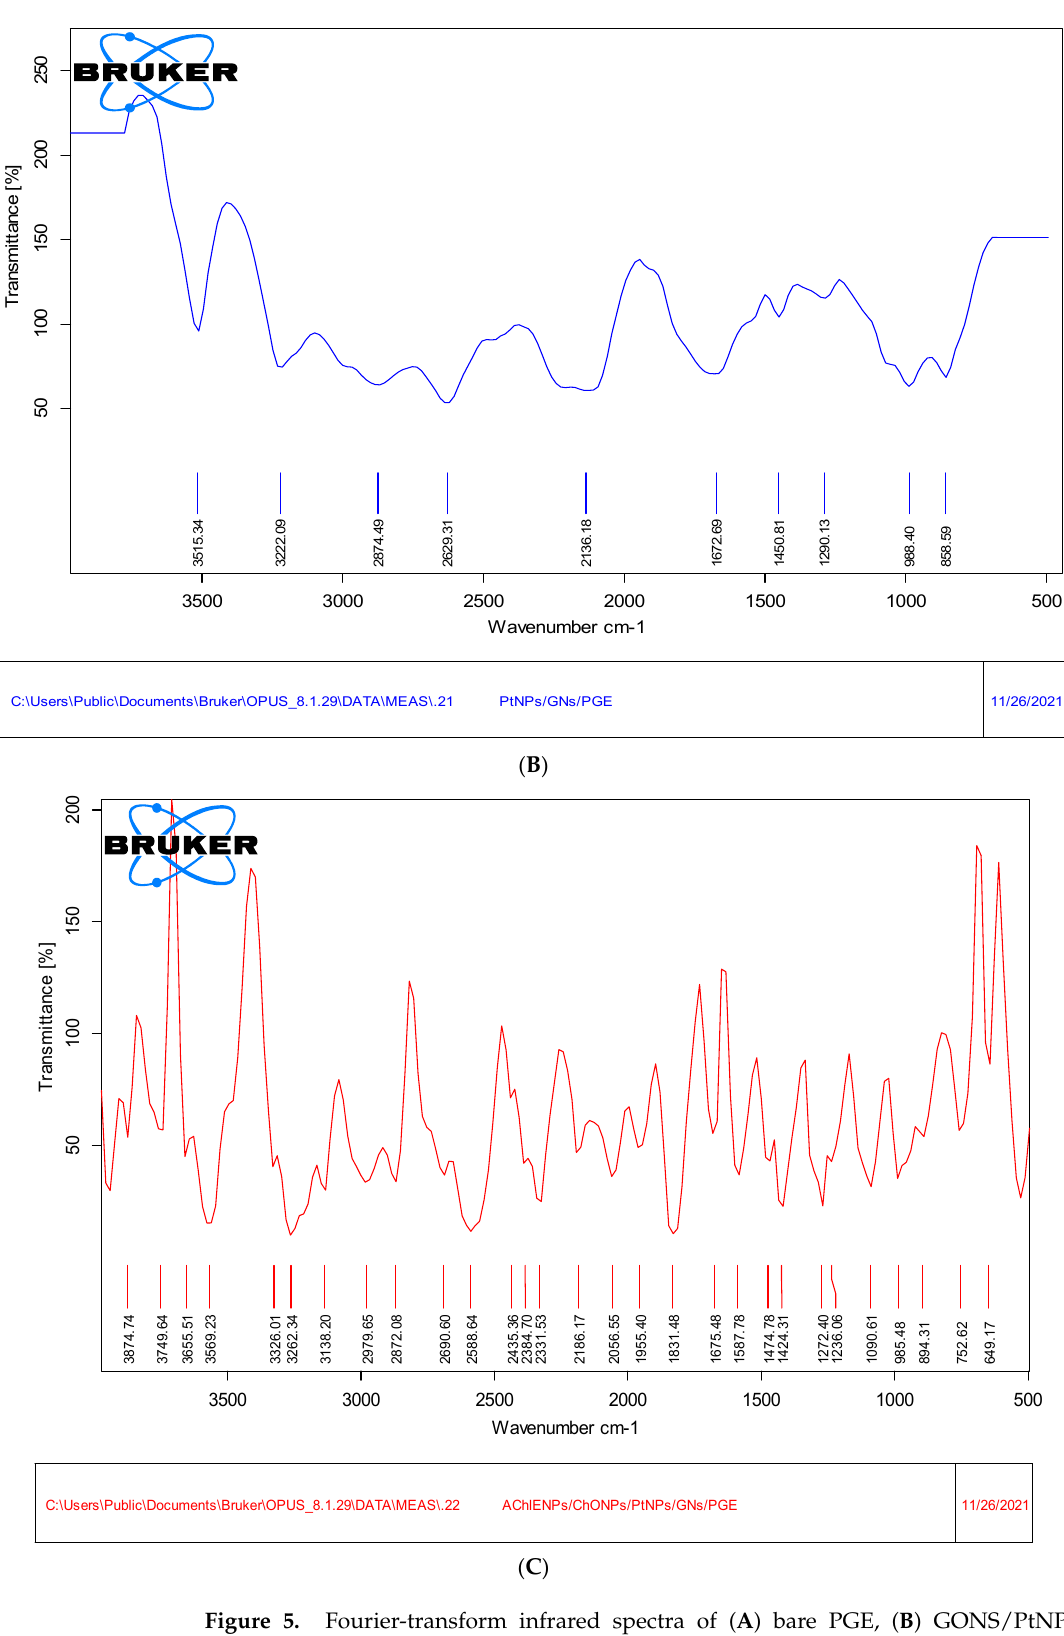
Figure 5. Fourier-transform infrared spectra of ( A ) bare PGE, ( B ) GONS/PtNPs/PGE and ( C ) AChENPs/ChONPs/GONS/PtNPs/PGE in the range 4000–500 cm − 1 . (AChENPs = Acetyl- choline esterase nanoparticles; ChONPs = Choline oxide nanoparticles; GONS = Graphene oxide nanosheets; PtNPs = Platinum nanoparticles; PGE = Pencil graphite